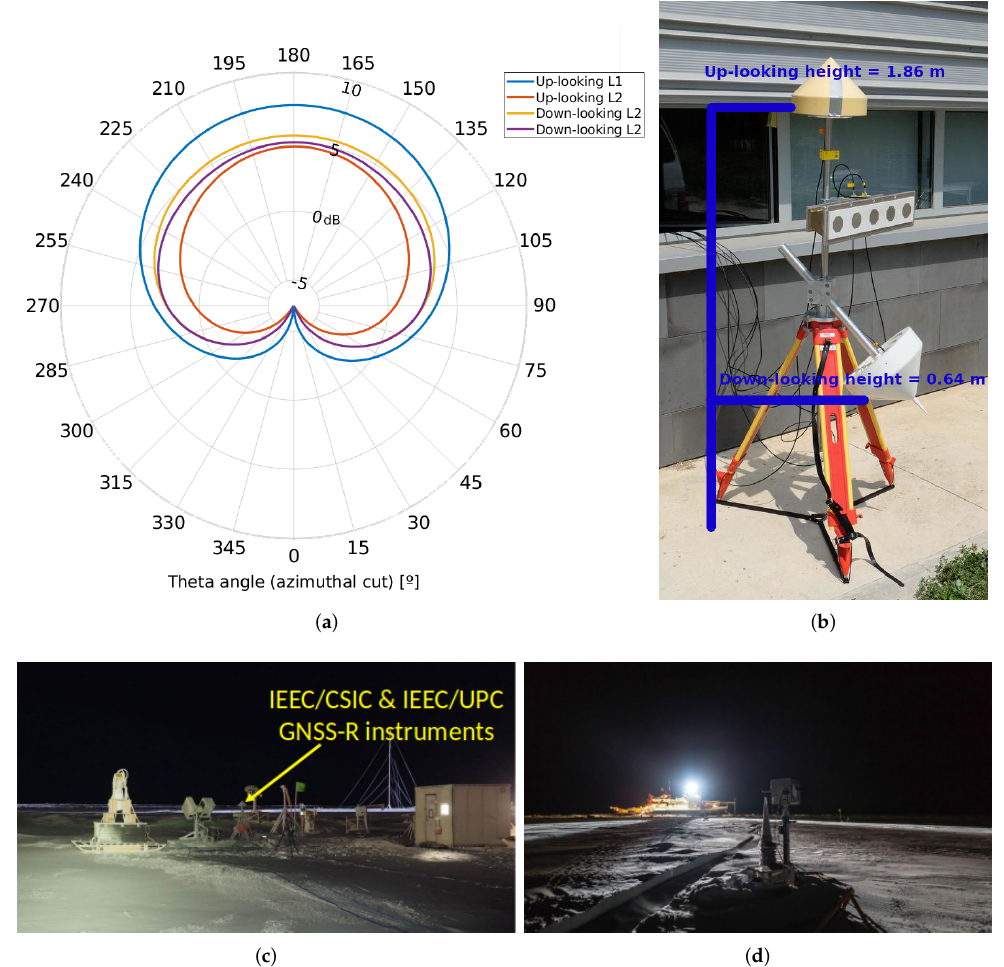
Figure 2. ( a ) Up-looking and down-looking antenna pattern; ( b ) antenna distribution and heights of each antenna; ( c ) MOSAIC Remote Sensing site with GNSS-R instruments (orange arrow), and ( d ) MOSAiC ice cracks during November–December 2019 [Credits: Gunnar Spreen and Stefan Hendricks].